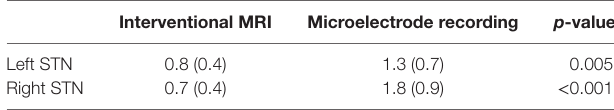
TaBle 2 | Means, SDs, and significance level of subthalamic nucleus (STN) lead to placement error in the axial targeting plane, in millimeters. interventional